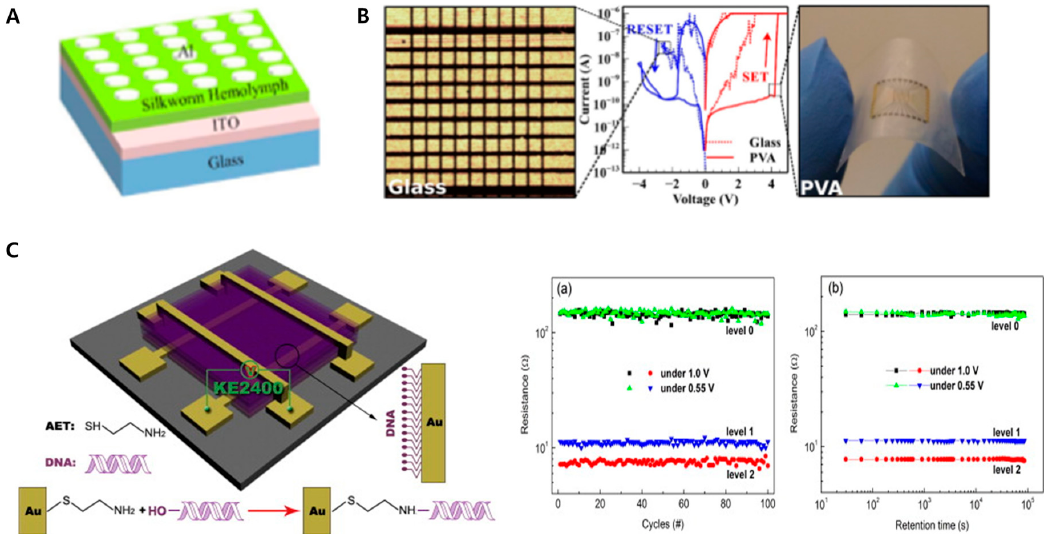
Figure 3. Biomemristor devices based on the proteins: ( A ) nonvolatile biomemristor device composed of the ITO, silkworm hemolymph protein, and an Al layers. used. Reproduced with permission from